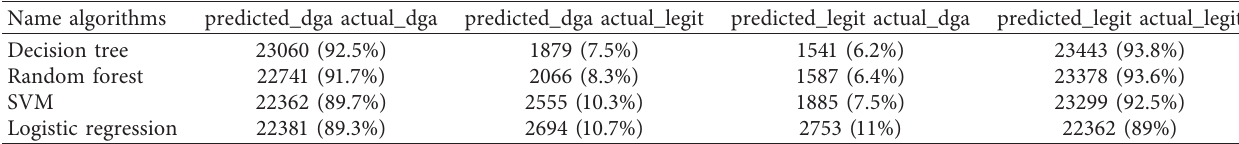
Table 4: Comparison of different algorithms without PCA